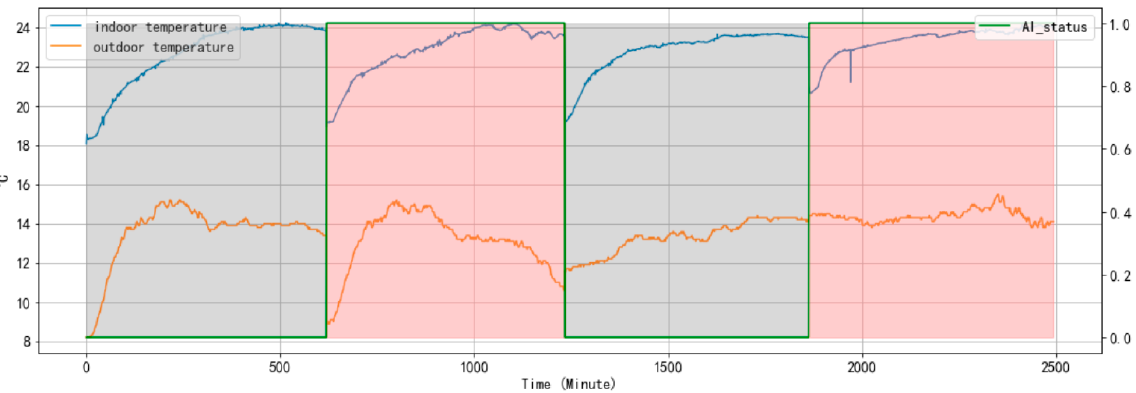
Figure 9. Temperature indoor and outdoor trends of AB tests (the grey area represents the AI_status is 0, the red area represents the AI_status is 1).